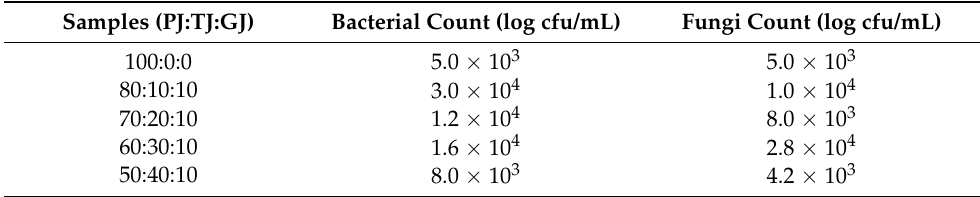
Table 5. Microbiological variations of Ginger, Pineapple, and Tumeric Juice Mix as influenced by